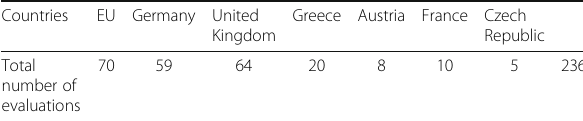
Table 1 Evaluations per jurisdiction